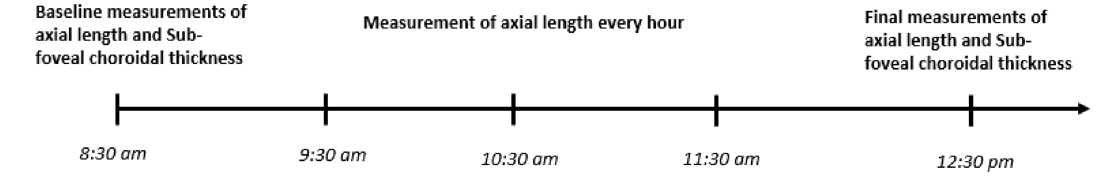
Figure 1. Schematic representation of the measurement procedure